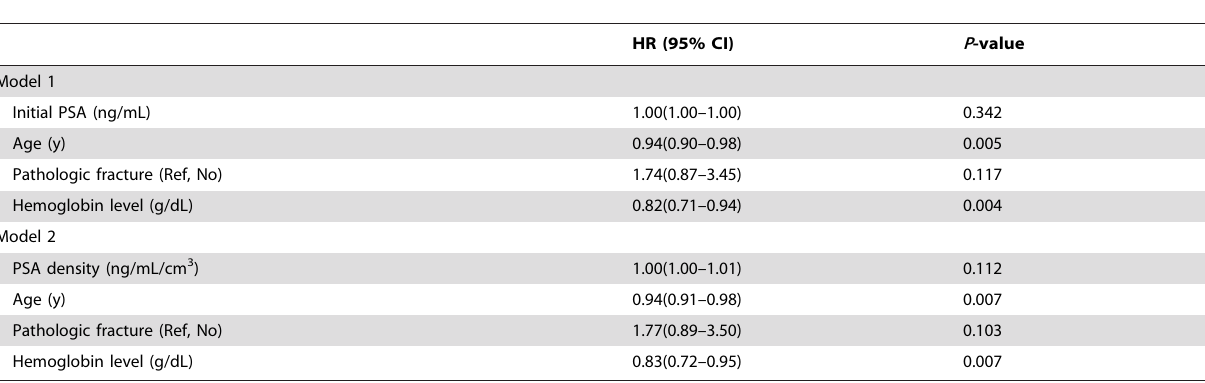
Table 4. Multivariate Cox regression analyses for